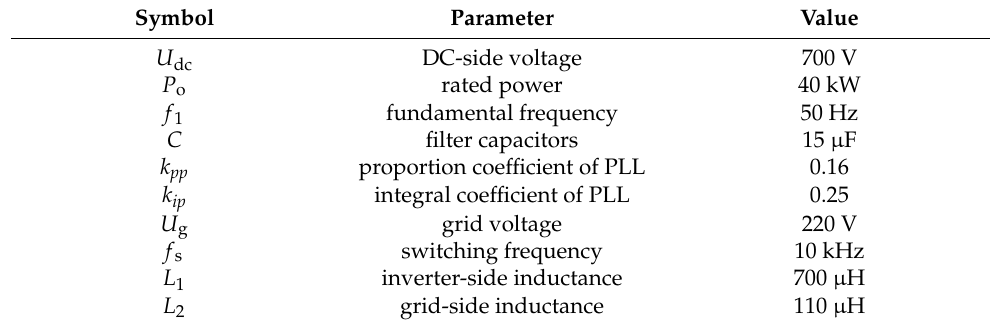
Table 2. Relevant parameters of LCL-TFSCI .